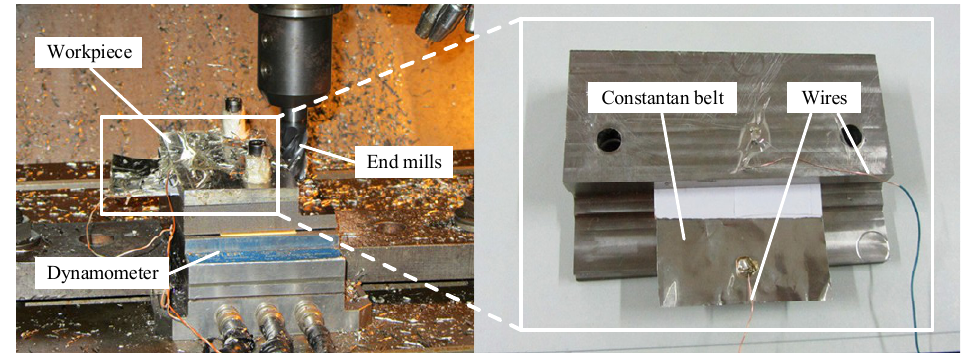
Figure 13. Experimental setup [34].